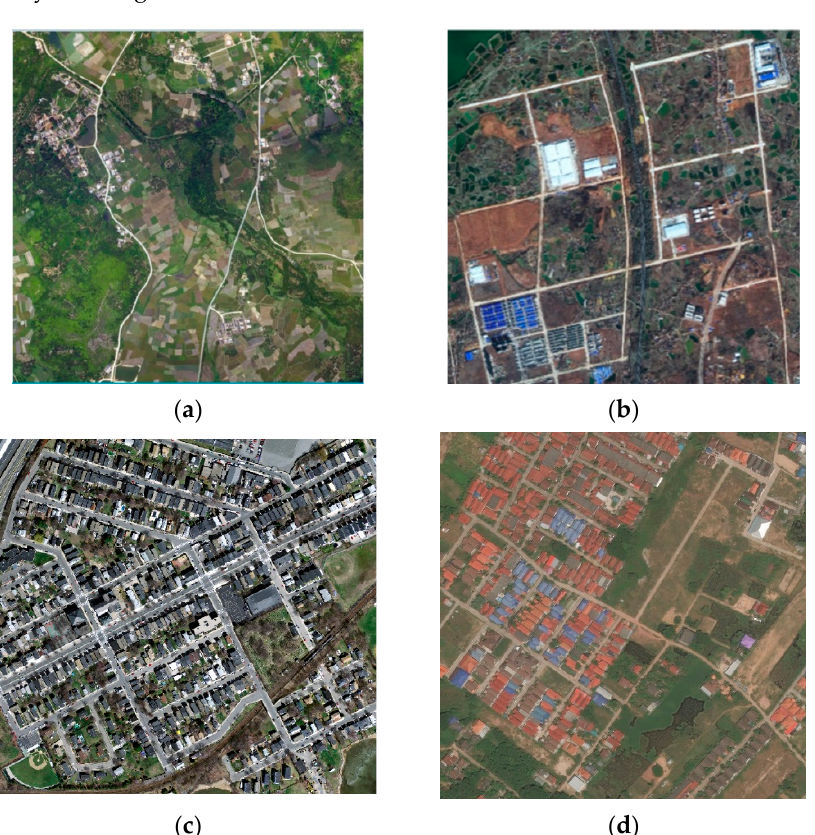
Figure 1. Experimental data: ( a ) Data 1 in a rural area, with a size of 5000 pixels × 5000 pixels and a spatial resolution of 0.2 m; ( b ) Data 2 in a suburban area, with a size of 5000 pixels × 5000 pixels and a spatial resolution of 1.0 m; ( c ) Data 3 in an urban area with a size of 630 pixels × 600 pixels and also a spatial resolution of 1 m; ( d ) Data 4 in a rural residential area with a size of 1024 pixels × 1024 pixels and a spatial resolution of 0.5